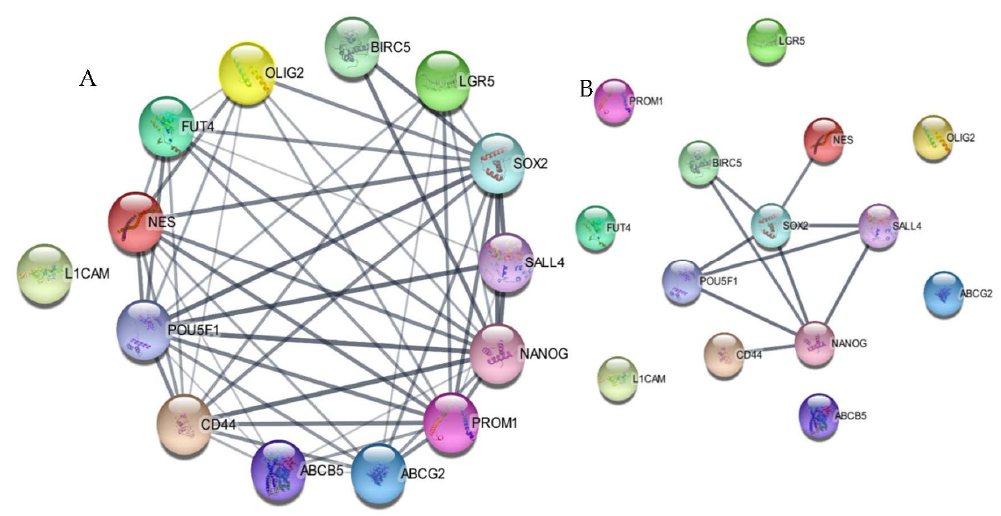
Figure 3. String analysis of the stemness genes using Cytoscape. ( A ) The protein − protein interaction (PPI) network of the genes with a confidence level of 0.4 with zero identifiers. ( B ) PPI network of the genes with a confidence level of 0.9 with zero identifiers, suggesting these genes to show significant interaction.